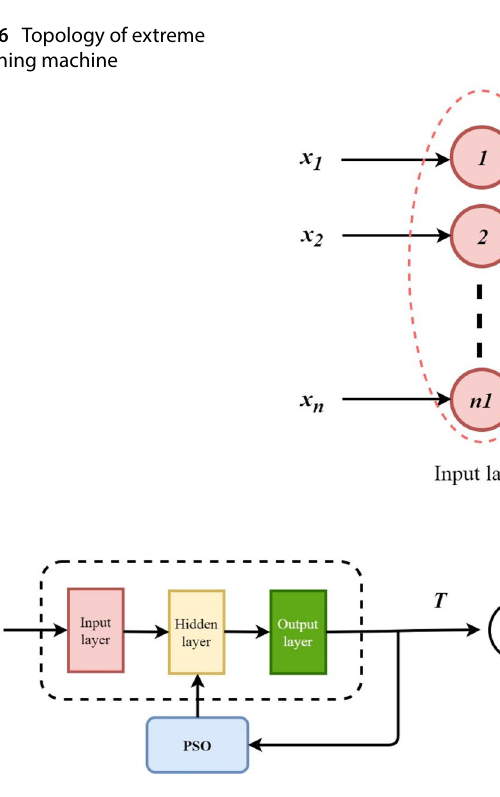
Fig. 7 PSO-based extreme learning